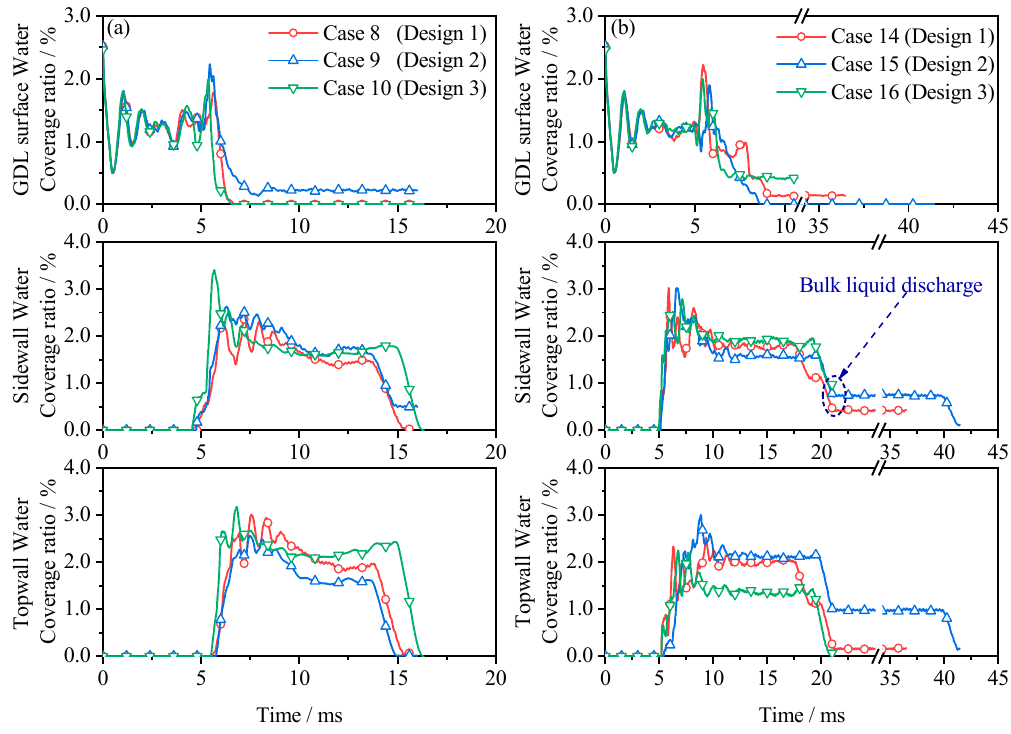
Figure 9. GDL surface water coverage ratio at different inlet velocities: ( a ) 12.5 ms − 1 ; ( b ) 10 ms − 1 .